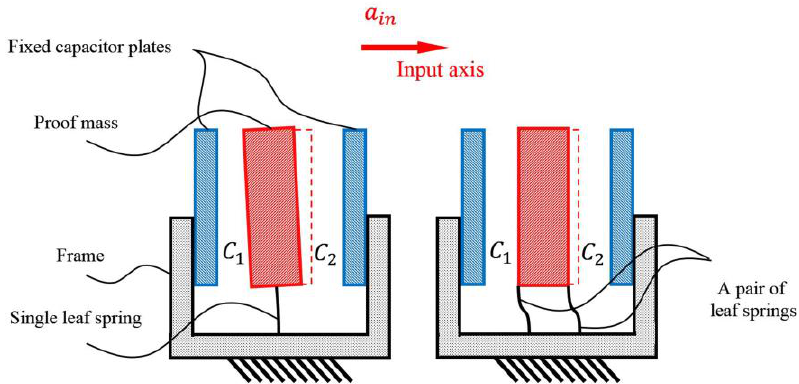
Figure 2. Comparison of the motion of the spring-mass structure with a single leaf spring and a pair of leaf springs, respectively.